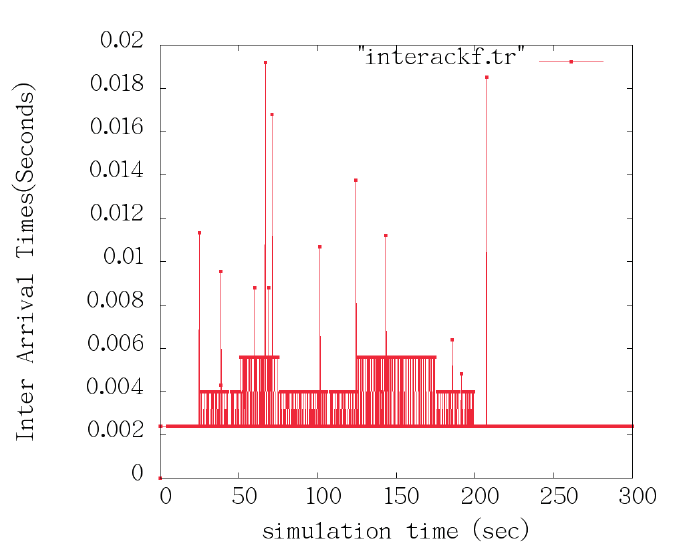
Figure 10. The time interval of ACK.